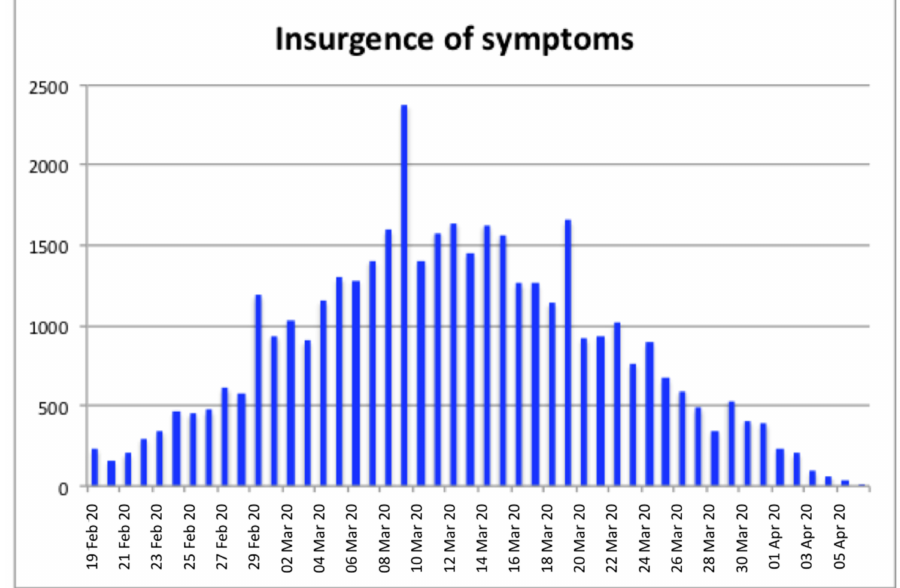
Figure 6. Number of infected people organized by date of insurgence of the first